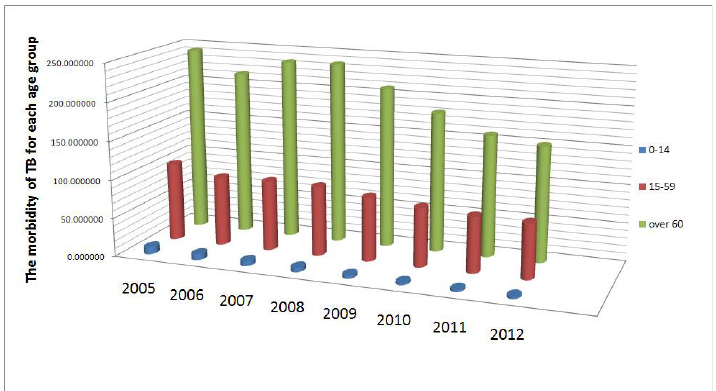
Figure 1. The tuberculosis (TB) morbidity based on age structure from 2005 to 2012 in China (source: CDC,